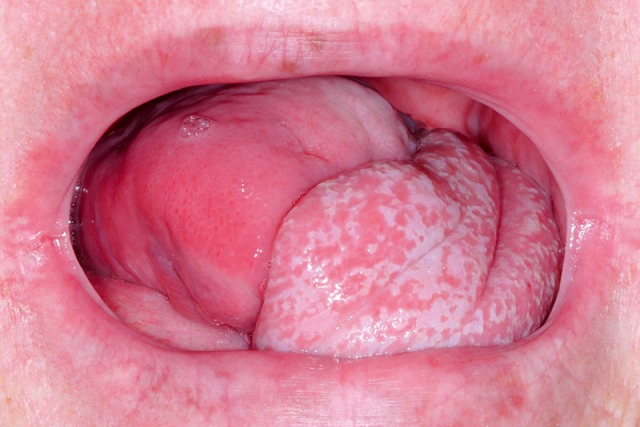
53-year-old female patient with left-sided reconstruction of the tongue after hemiglossectomy. Combined radial flap with neurovascular, infrahyoid, myofascial flap according to Remmert. Partially disturbed bolus transportation in the oral phase.